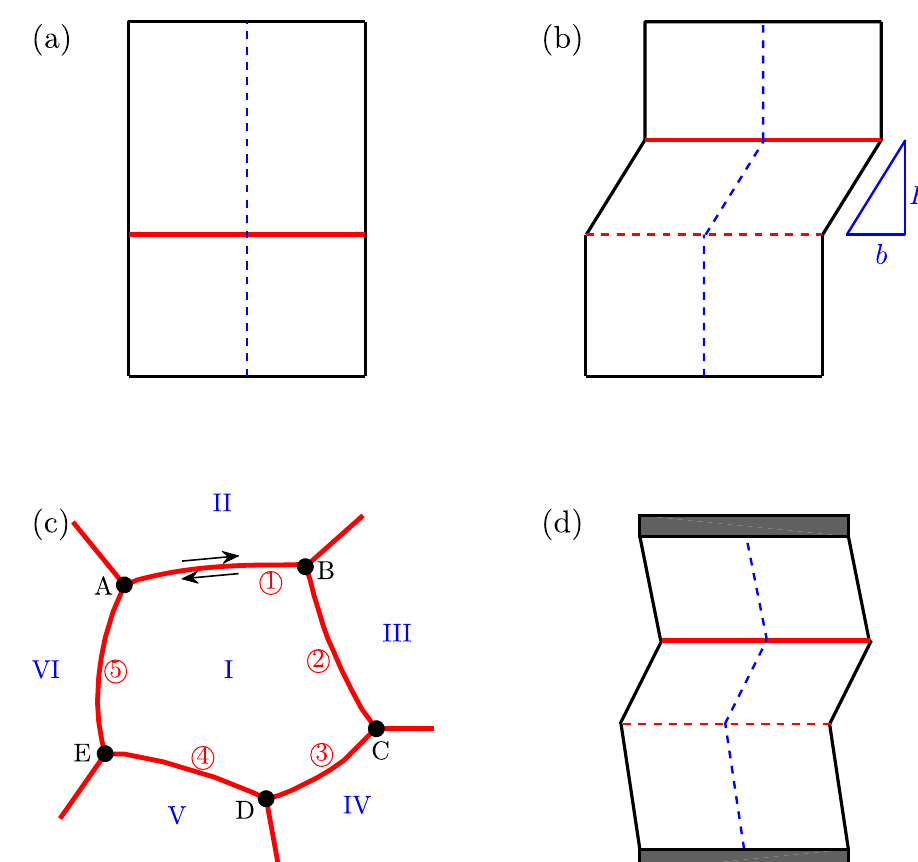
Fig. 1 Schematic illustration of shear coupling and constraints during GB migration. A bicrystal with free top and bottom surface a before and b after GB migration with accompanying shear deformation. The dashed blue line is a fi ducial marker (e.g., a scratch) in the bicrystal. The shear-coupling factor β is the inverse of the slope of this line between the initial and fi nal GB positions (red solid and dashed lines in b , respectively). c A grain in a polycrystal with GBs 1 – 5 and Junctions A – E. The shear of GB ① is constrained by junctions A and B and by the elastic interactions between Grain I and surrounding grains, III – VI. d GB migration in the bicrystal of a where the top and bottom surface do not translate to mimic the effects of Grains IV and V on the shear of GB ①